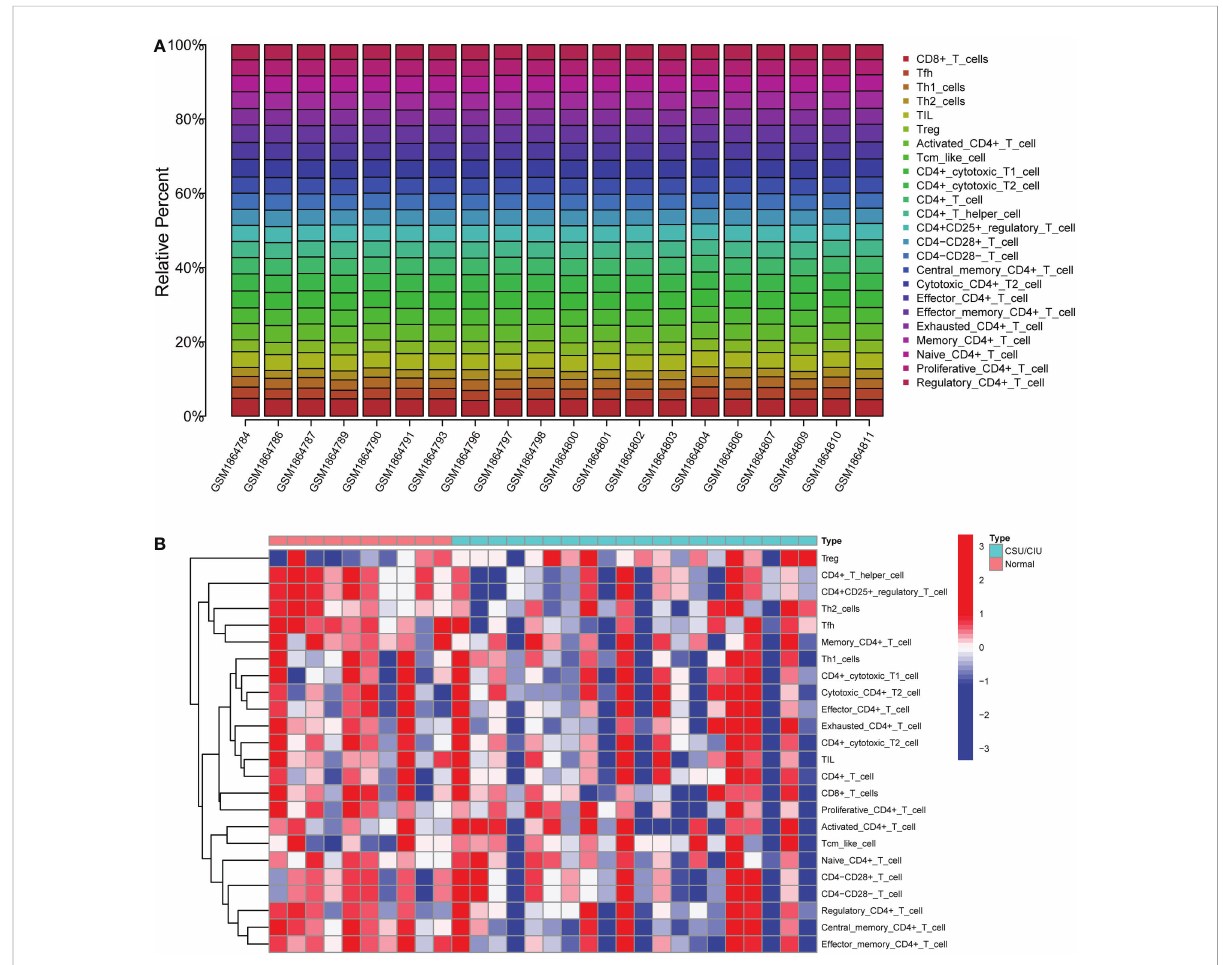
FIGURE 3 The pro fi les of immune cell subtype distribution and correlation in GSE72541 cohorts. (A) Stacked graph of different types of immune cell proportion in CSU patients. (B) Heatmap of immune cell distribution in 30 samples. CSU, chronic spontaneous